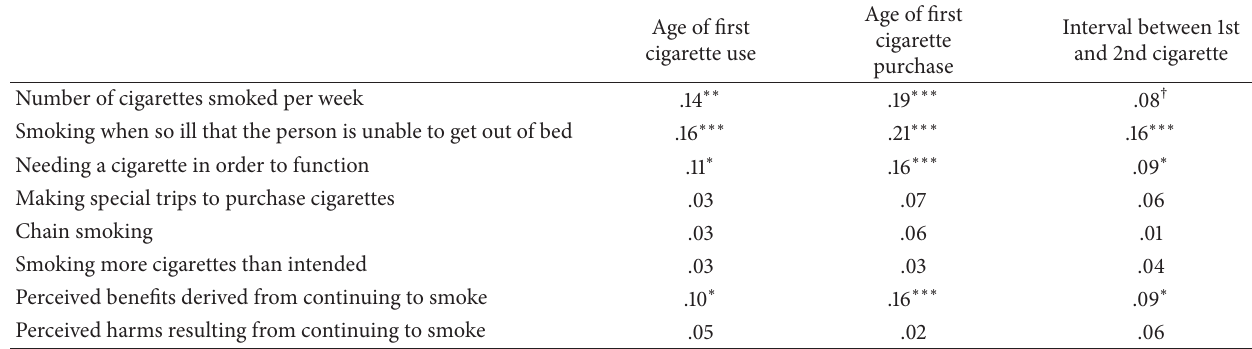
Table 1: Age of onset of tobacco use and subsequent smoking